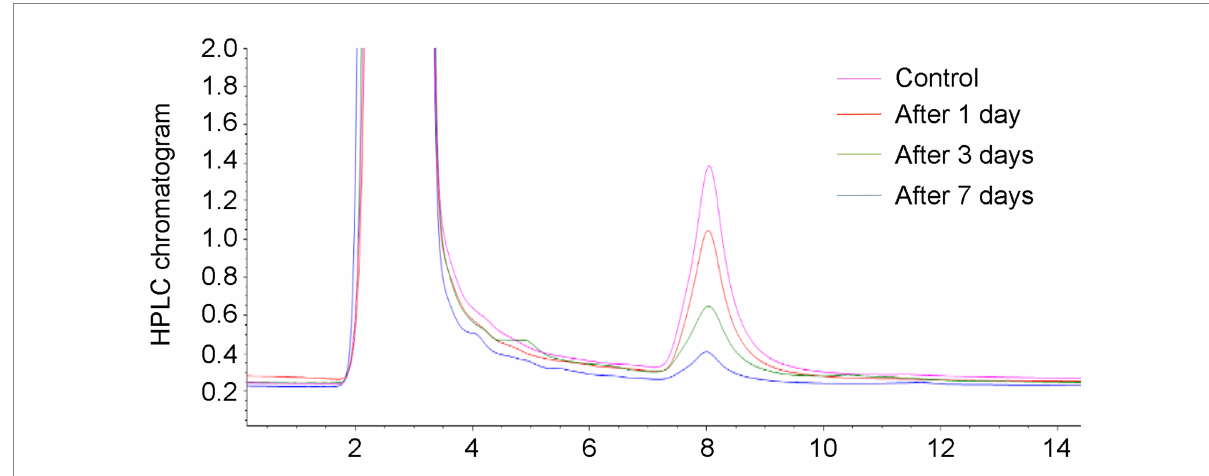
FIGURE 1 Chromatograms relevant to the aflatoxin B 1 (AFB 1 ) (50 ng/kg) in the control and YPD liquid medium after 1, 3, and 7 days of removal by a Trichoderma